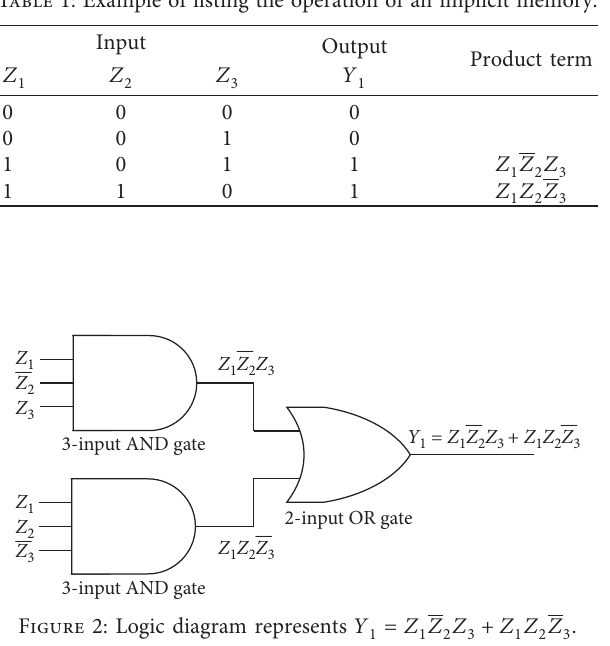
� Z Z Z + Z Z Z 1 1 2 3 1 2 3